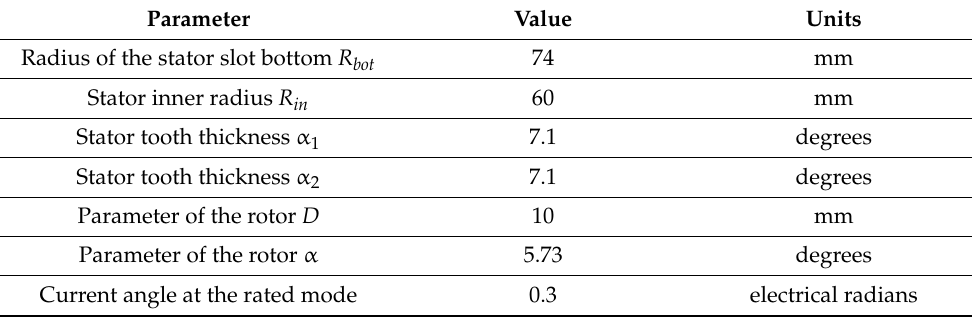
Table 6. Initial values of the IPMSM parameters varied during the